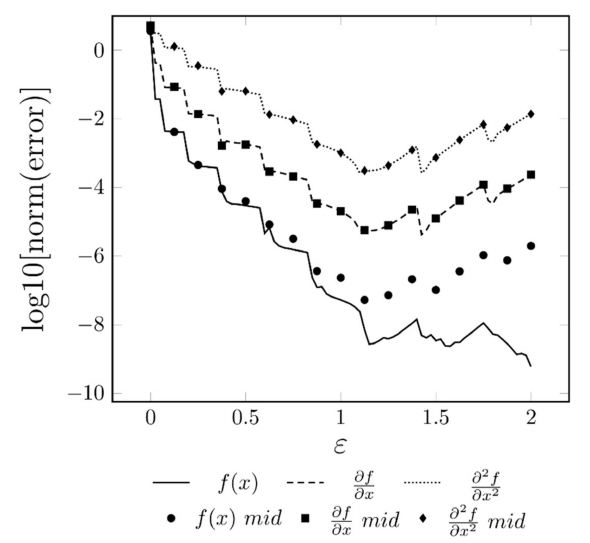
Figure 4. The error of approximating the given function f ( x ) and its first two derivatives using the conventional RBF approach as it varies with ε . The Gaussian radial basis function is used and the number of mesh points is fixed as 41 regularly distributed points.